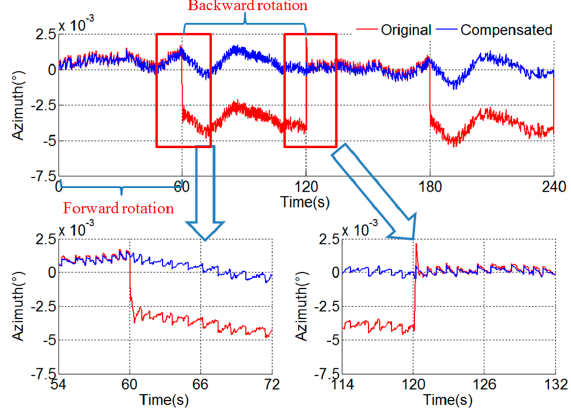
Figure 10. Result of compensation of asynchrony between gyroscope and angular encode.